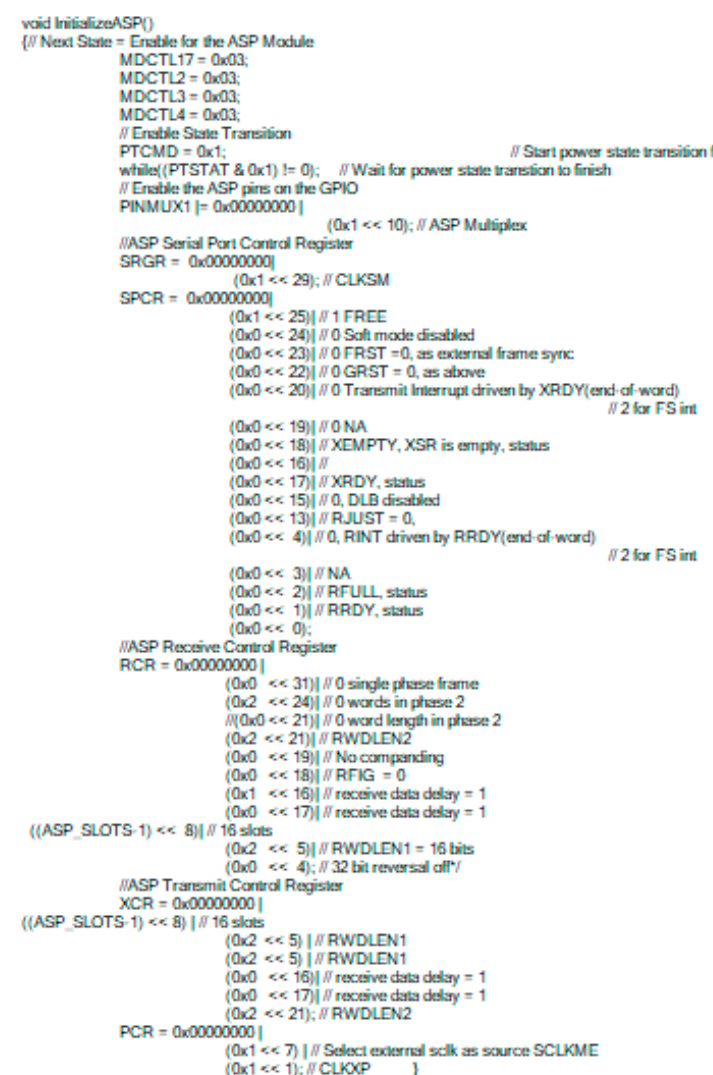
Figure 7. Real-time embedded system under test.